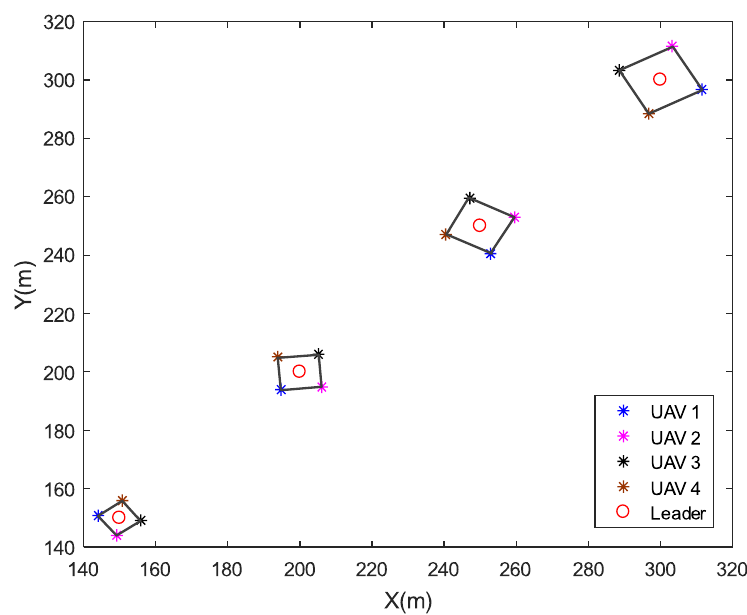
Figure 5. Position of four UAVs and the leader at t = 30,40,50,60 s